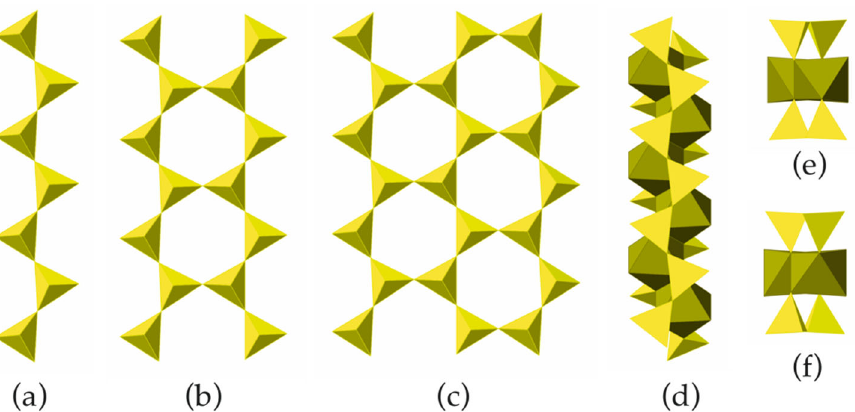
Figure 6. The members of the [Si 2 M O 5 M +1 ] chains with M = 1 ( a ), 2 ( b ) and 3 ( c ); the I ‐ beam viewed perpendicular to its extension ( d ) and two views of the I ‐ beam parallel to its extension featuring two possible orientations ( e , f ).